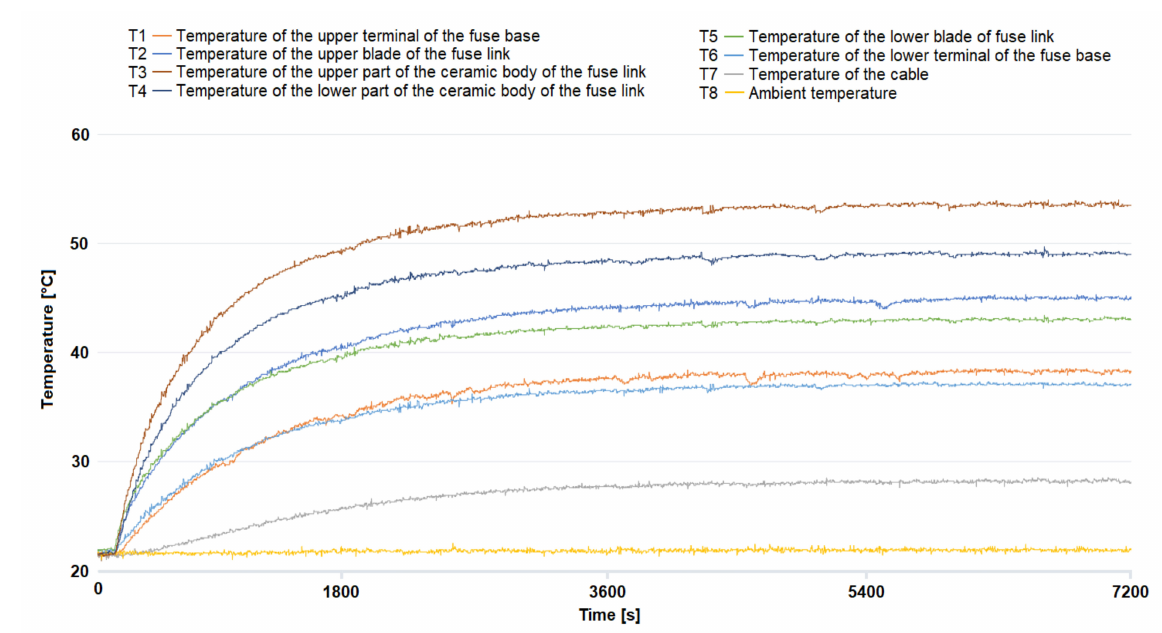
Figure 4. Chart showing results for thermocouples T1; T2; T3; T4; T5 and T6. The results were obtained for a time of 7200 s for a type of fuse NH000 gG 100 A and for a current of 100 A.